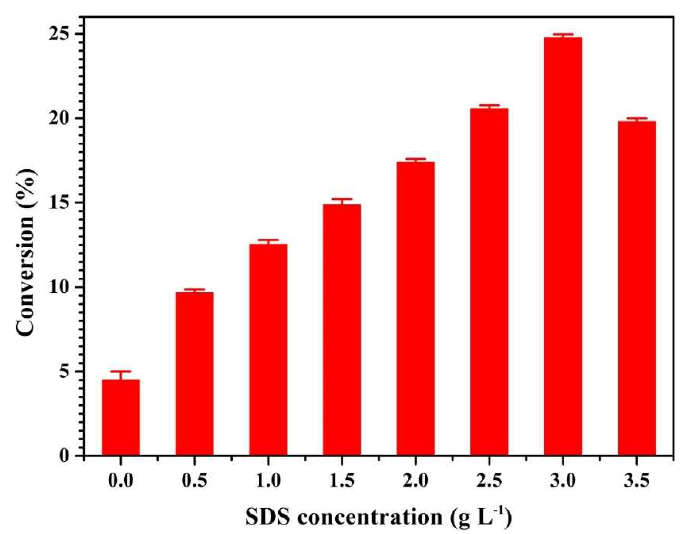
Figure 1. Conversion degree of free − NH 2 groups at 5% ( w / w ) gelatin with the increasing of sodium dodecyl sulfate (SDS) concentration from 0 g L −1 to 3.5 g L −1 . Data represent mean ± SD, N = 3.